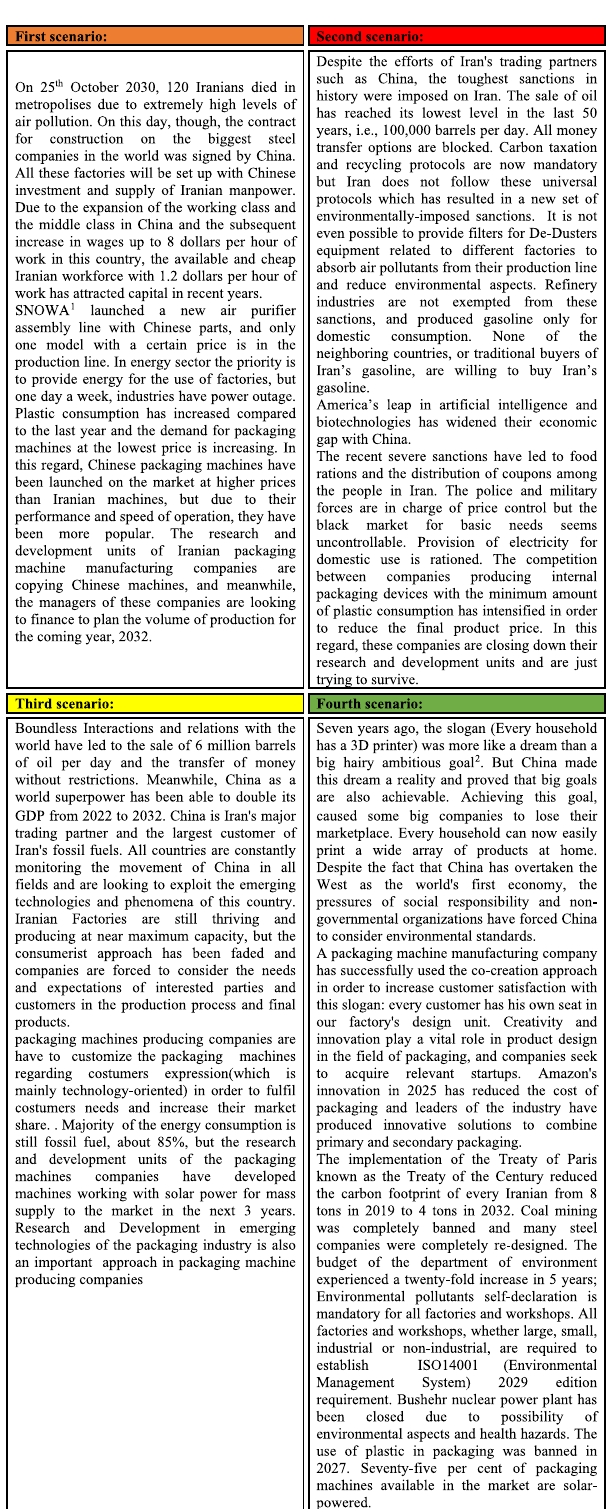
Fig. 4 A short narrative of constructed